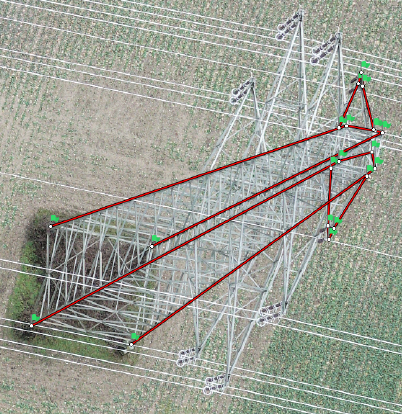
Figure 5: Power tower drawn by hand in Agisoft, similar results can be obtained with other photogrammetric